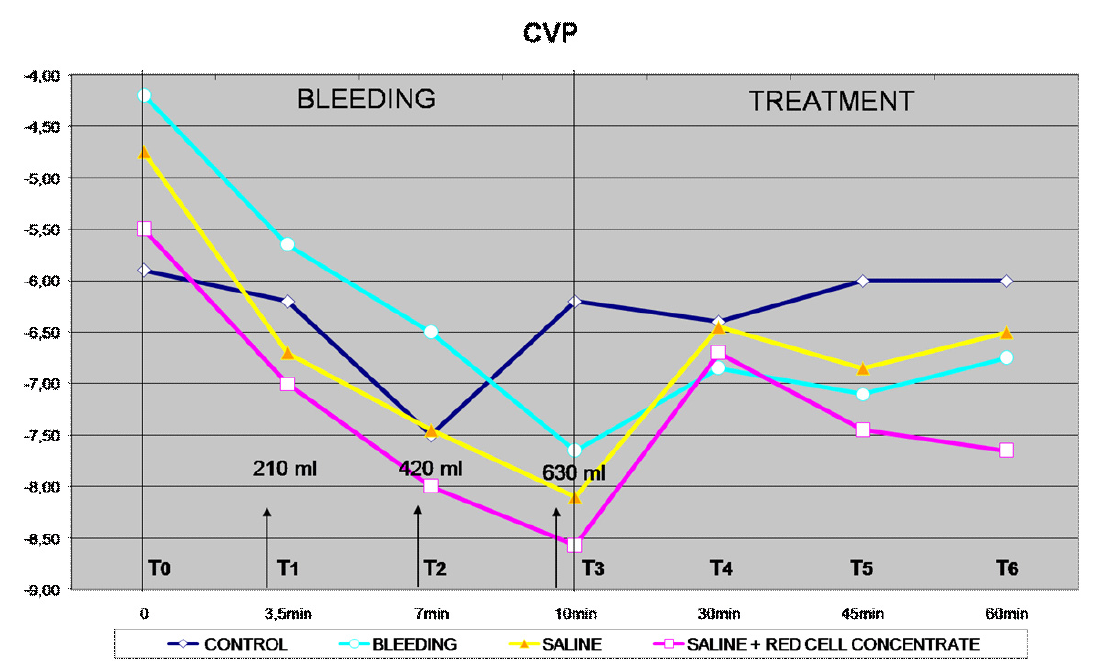
FIGURE 3 - Evolution of the central vein pressure after the hemorrhagic insult and resuscitation